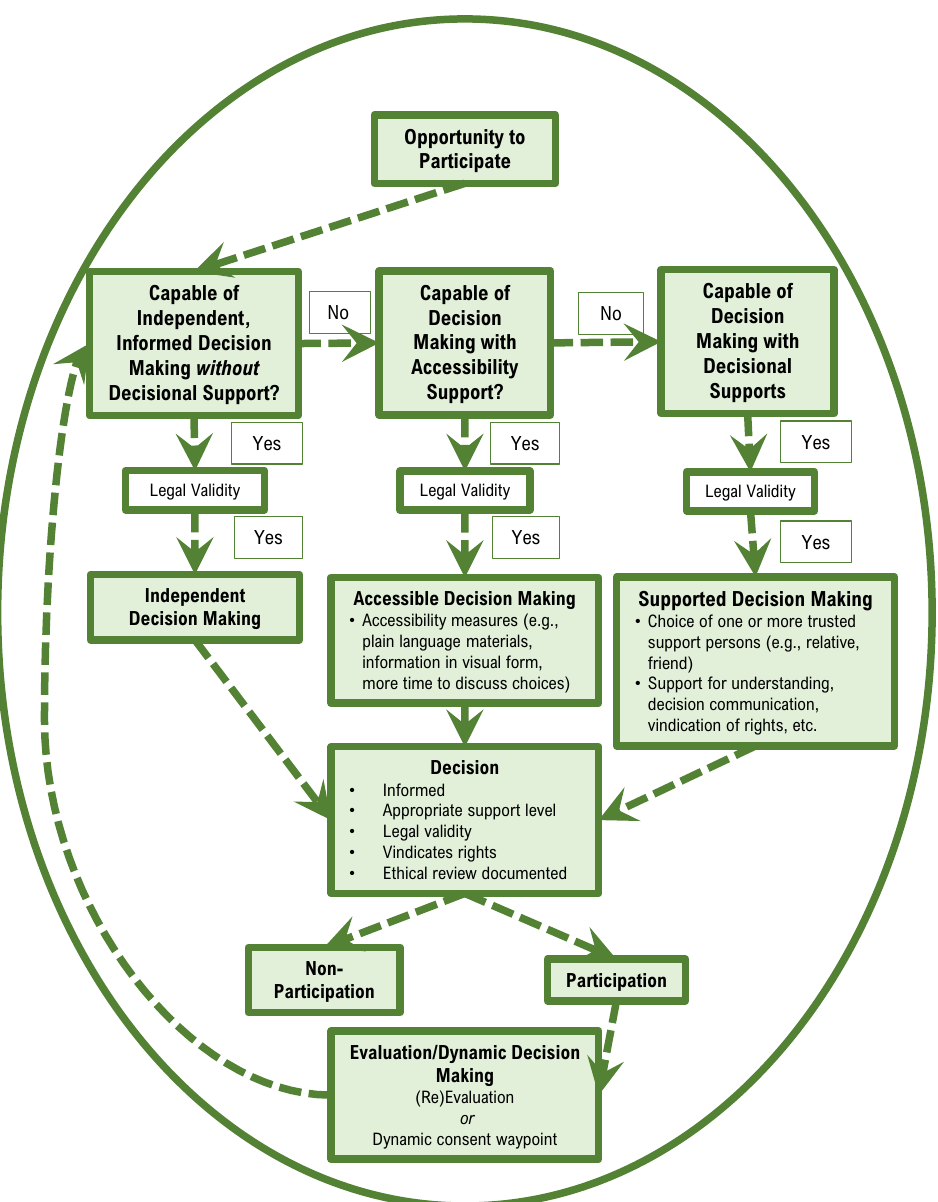
Figure 1. SHAPES human rights–based informed consent